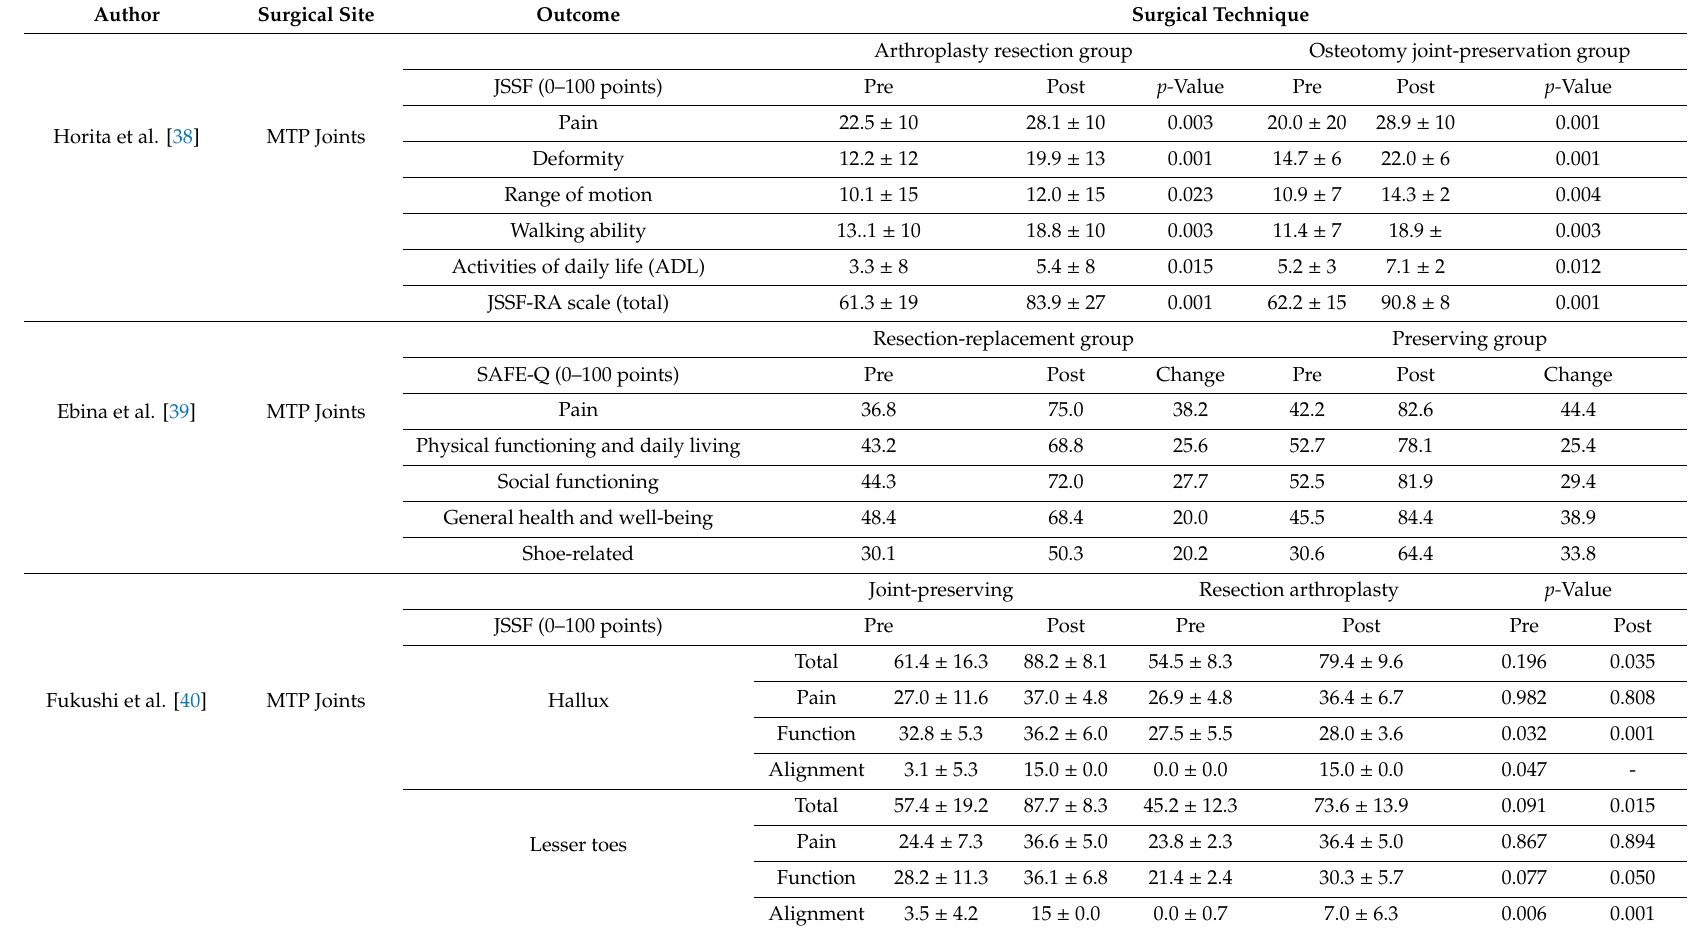
Table 3. Outcomes in pain relief and functional capacity in included